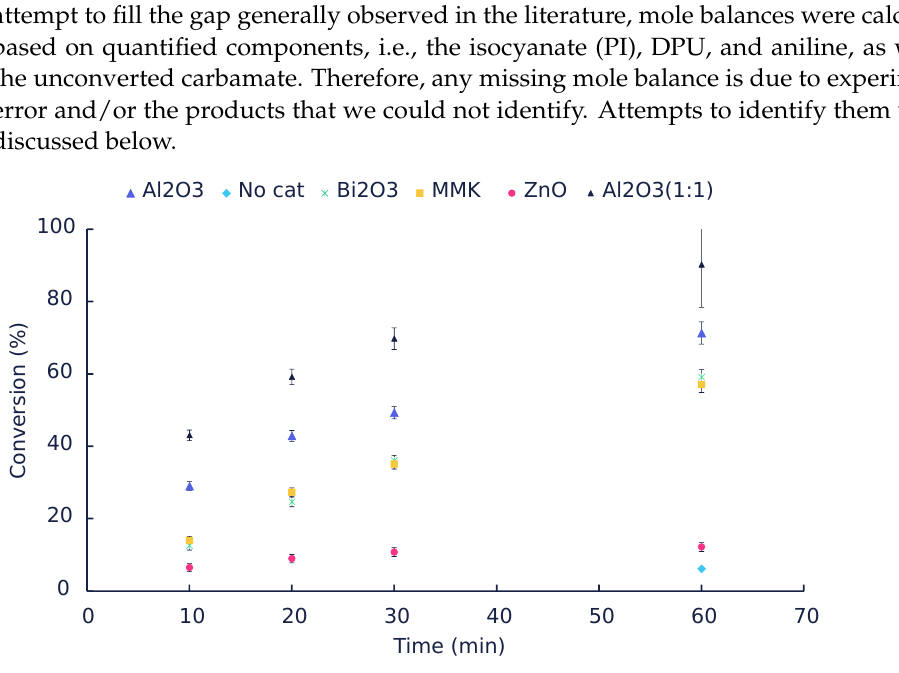
Figure 2. The catalytic performance of ZnO, Al 2 O 3 , Bi 2 O 3 , and MMK vs. time. (the catalyst to feed ratio is 6:10 unless stated